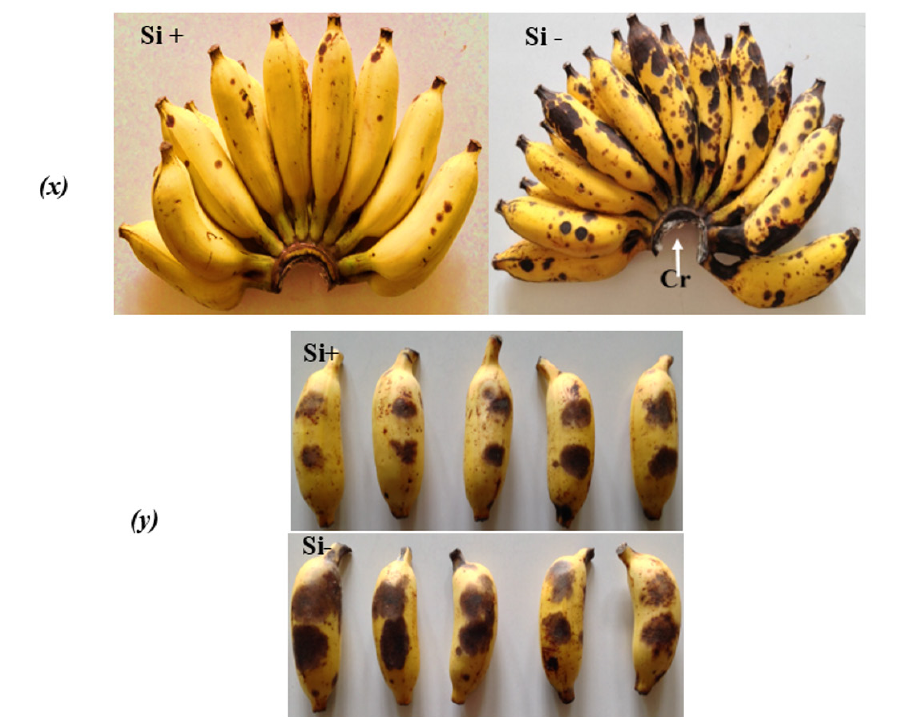
Figure 1: ( x ) Crown rot development (Cr) on fruits (Si+) and (Si-) at 14 d after challenged inoculation with Lasiodiplodia sp. ( y ) Development of anthracnose symptoms in (Si+) and (Si-) banana 12 d after challenge inoculation Colletotrichum